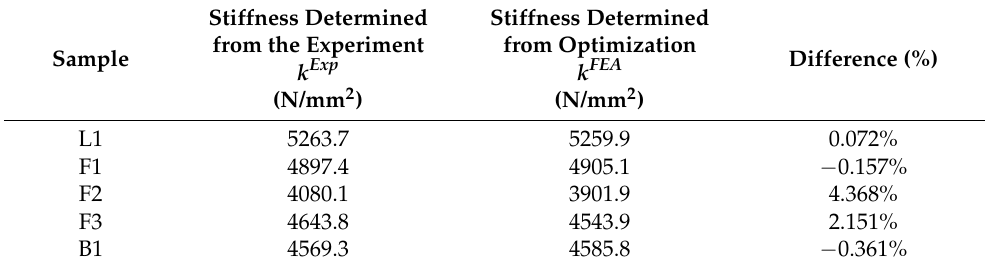
Table 8. Comparison of sample stiffness with the parentage difference.